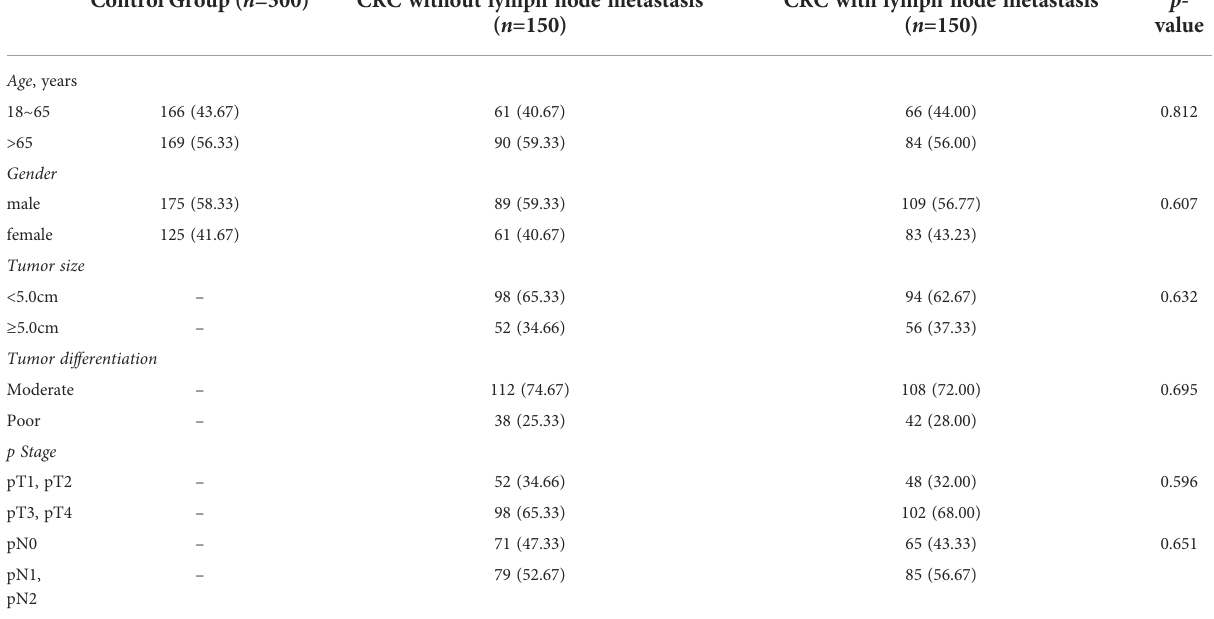
TABLE 1 Patient